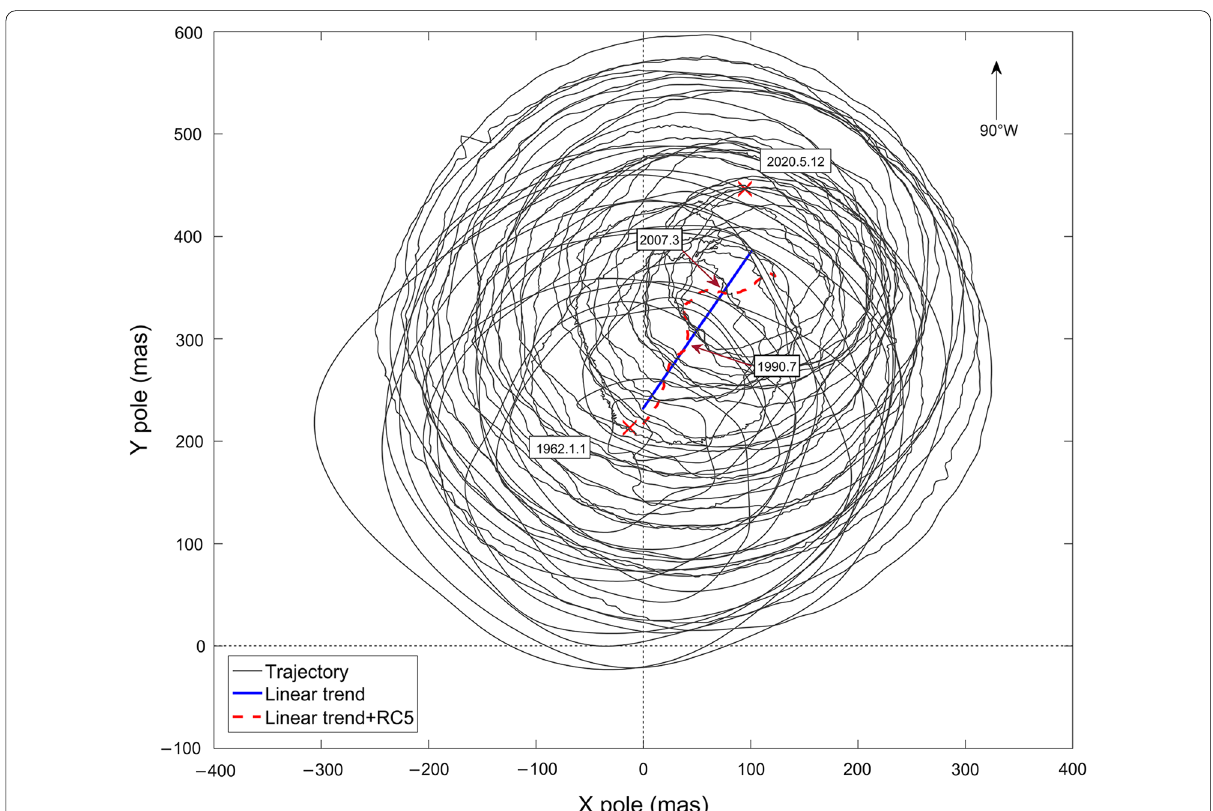
Fig. 5 Trajectory and trend of PM. The gray line represents the trajectory of PM. The red cross indicates the position of the start and end times of PM trajectory. The blue solid line and red dashed line is the linear and nonlinear trend term of PM, respectively